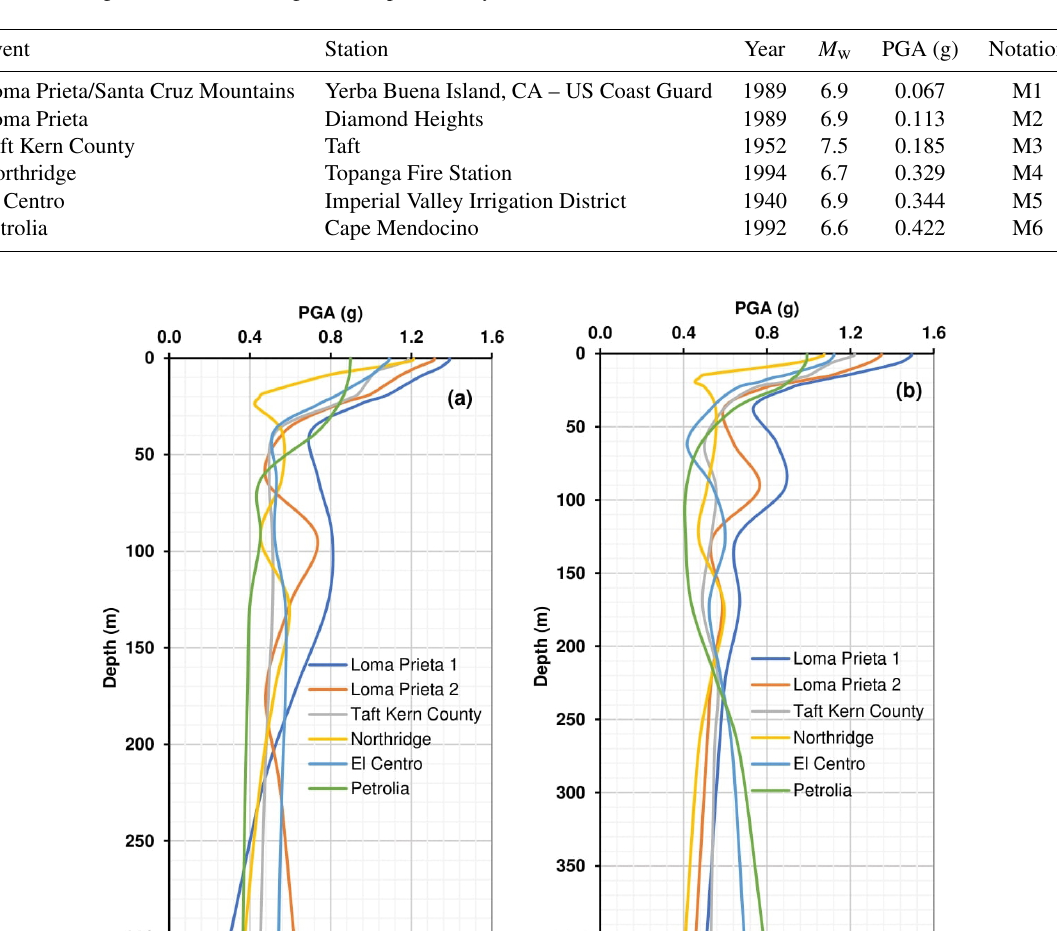
Figure 7. The typical profiles of normalized peak ground acceleration (PGA) at (a) Toorsa II in Zone I and (b) CST football ground in Zone